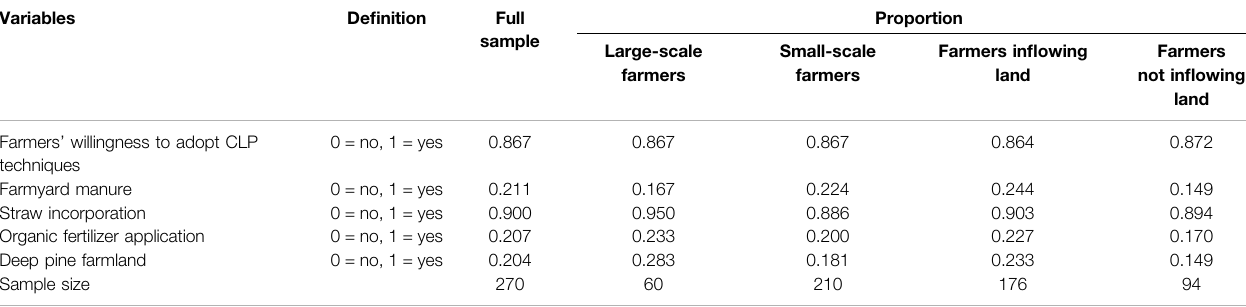
TABLE 1 | Proportion of farmers choosing CLR (%).